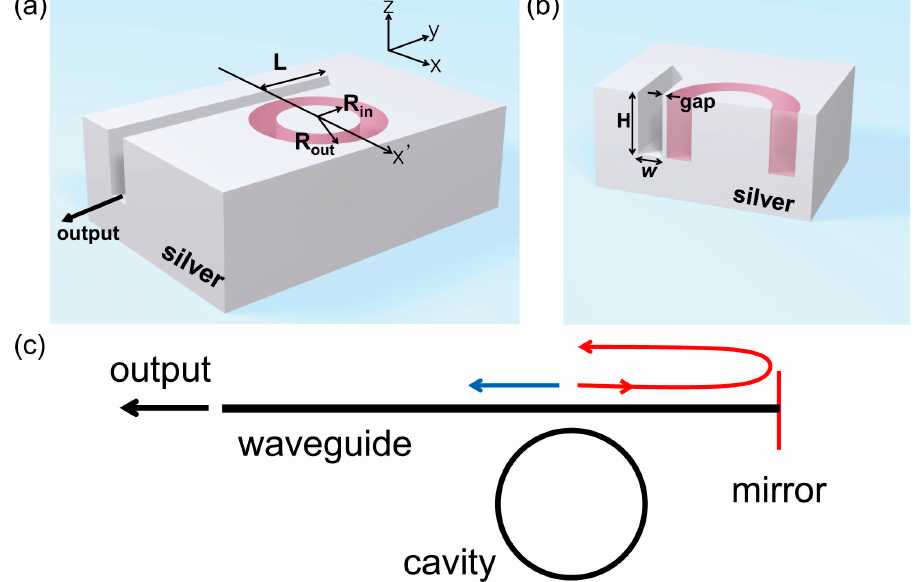
Figure 1. ( a ) A schematic diagram of the plasmonic ring cavity index sensor with a waveguide output port. The ring cavity (indicated by purple color) is filled by a light emitting material with a refractive index of 1.47. The waveguide and cavity, with rectangular cross-sections, are formed on the silver substrate. The right end of the waveguide is blocked by a silver wall, and the length to the right end from the coupling point is represented by L . All empty spaces including the waveguide are filled by an analyte. ( b ) A cross-sectional view of the ring cavity and waveguide along the x ′ axis, indicated in Figure 1a at the coupling point. The waveguide has a groove with a rectangular cross-section with a width of w and a depth of H in the silver substrate. ( c ) A conceptual figure of a phase sensitive sensor. The blue and red arrows indicate the left and right propagating light coupled from the cavity into the waveguide, respectively.